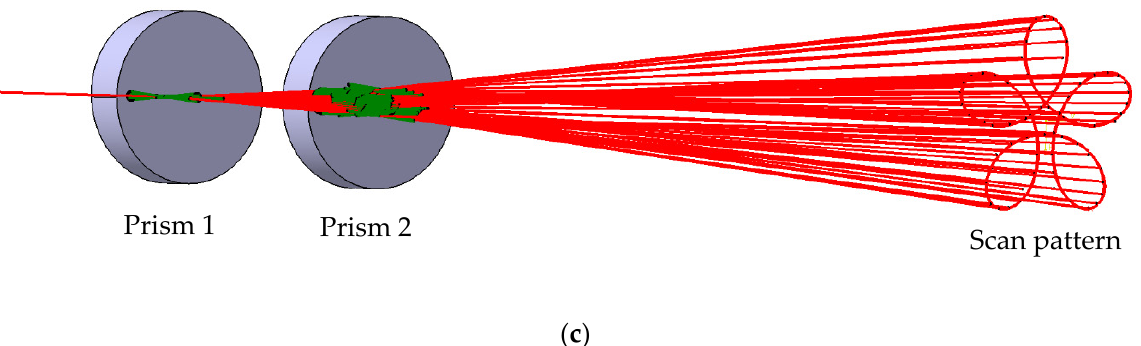
Figure 1. ( a ) Pair of rotational Risley prisms, modelled with a commercially-available mechanical design program, CATIA V5R20. ( b , c ) Two light bundles generated with CATIA V5R20 in the simulation of scanning with a pair of rotational Risley prisms. As a color convention throughout the entire study, scan patterns obtained for prisms rotating in the same direction are presented in blue, while patterns of prisms rotating in opposite directions are presented in red. Details are presented in the text.